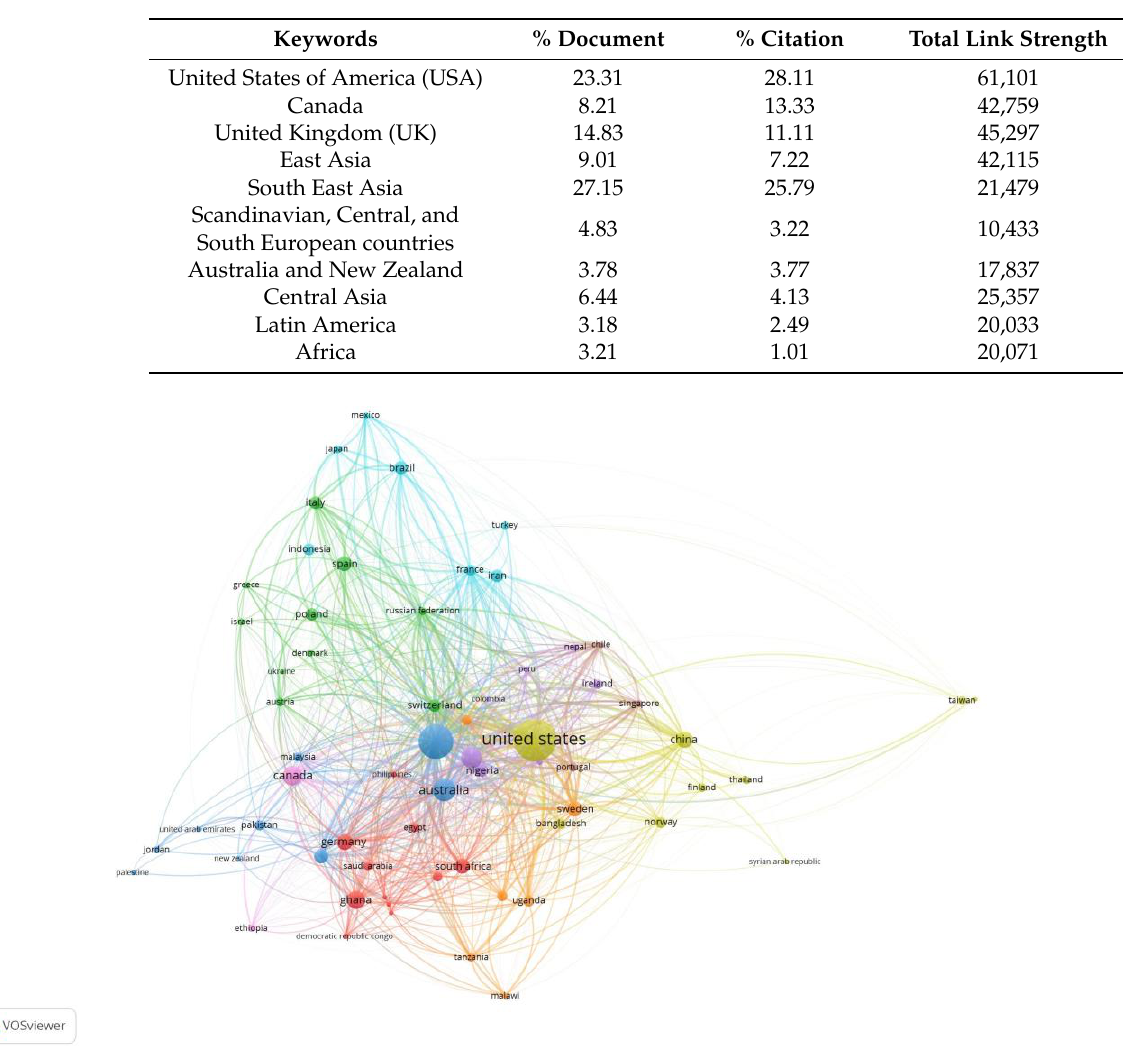
Figure 2. Geographic location cluster.